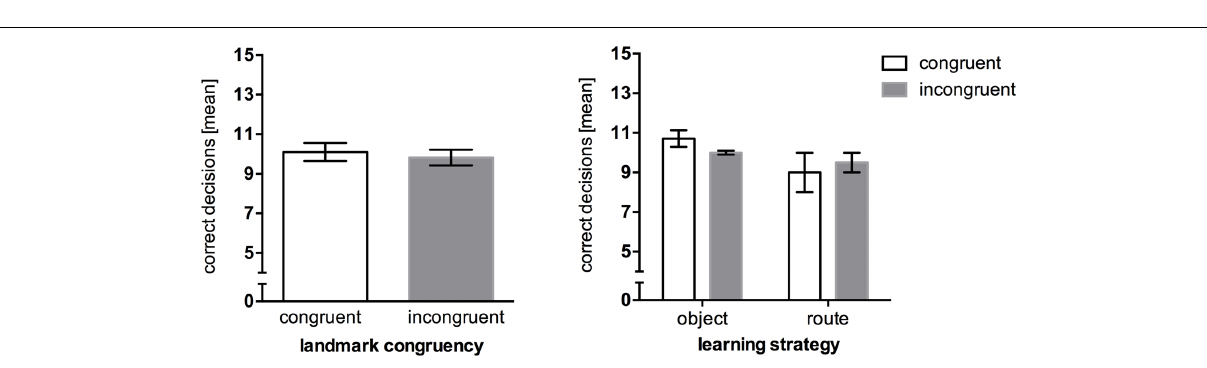
FIGURE 3 | Mean correct route decisions in the wayfinding task of Experiment 2, error bars represent the SEM, chance level = 5. (Left) Comparison between wayfinding performance in the congruent landmark condition and the incongruent landmark condition. (Right) Wayfinding performance between congruency levels after post hoc categorization of